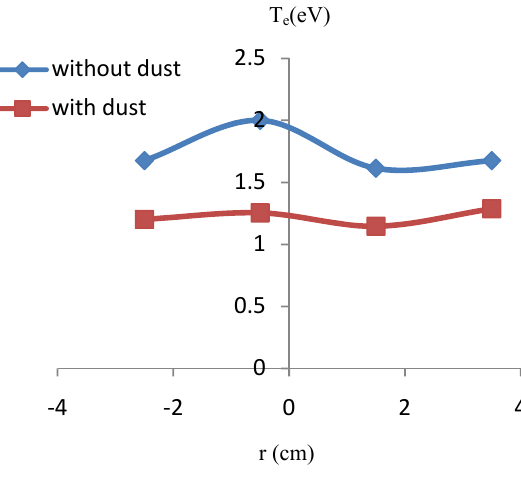
Fig. 14:Influence of Al dust on the radial profile of electron